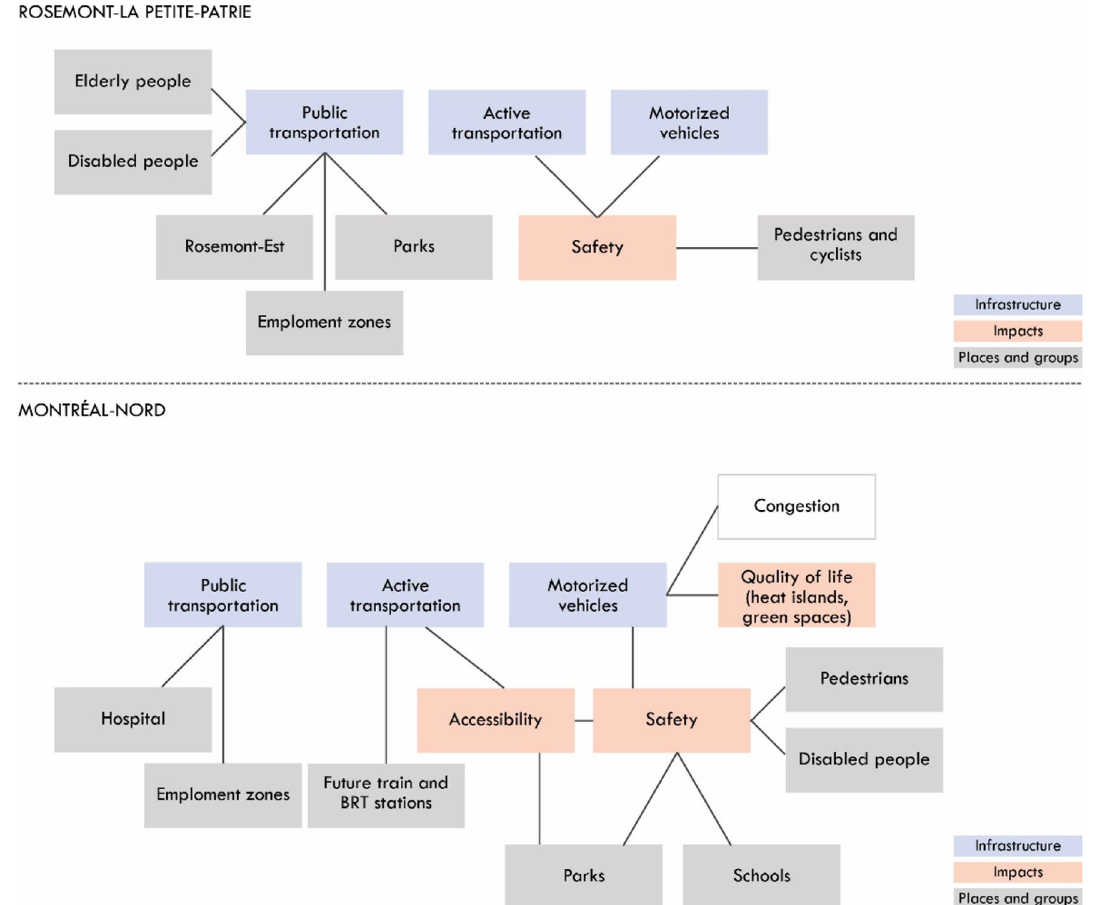
Fig. 3 Tree diagrams illustrating the issues, and their interrelationships, reported from the participatory process in Rosemont-La-Petite-Patrie. And